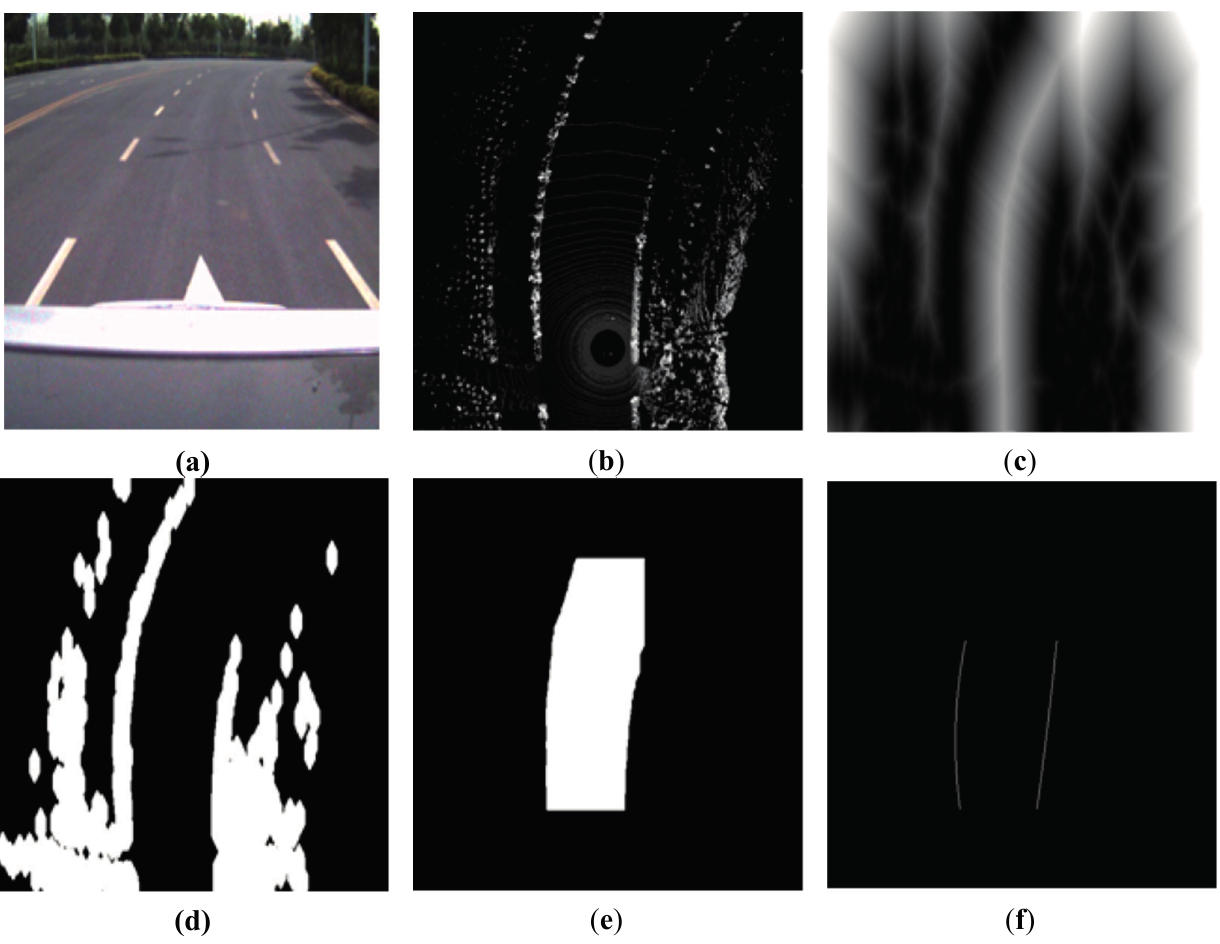
Figure 6. Example of road curb detection. ( a ) Original image obtained by the camera that describes the local environment; ( b ) Original grid map obtained by the Velodyne LIDAR; ( c – f ) Results for Steps 1–4,